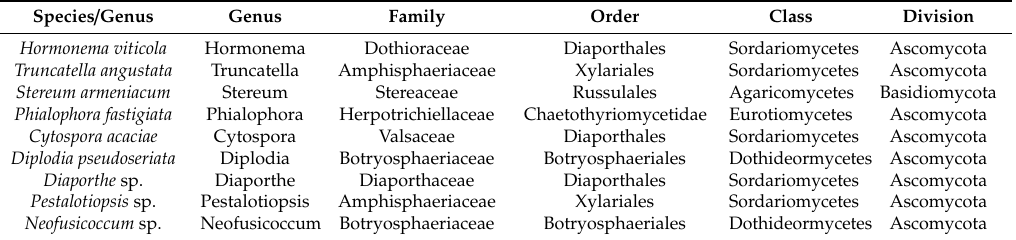
GTDs: grapevine trunk